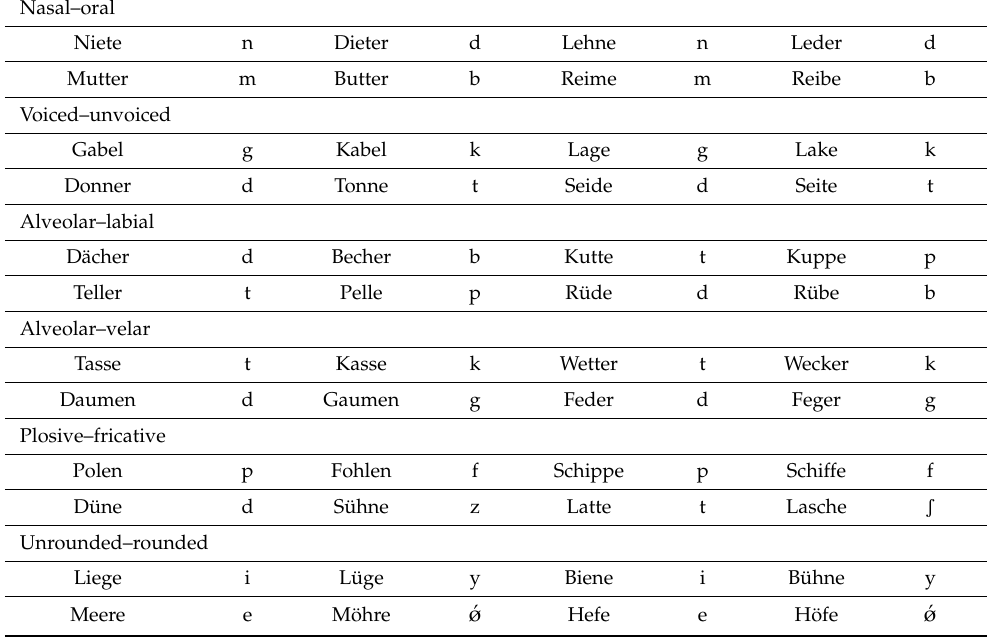
Table A5. CV syllables (parameter SYLL) . The consonants were evaluated for the accurate realiza- tion of place, manner, voicing, and nasality.